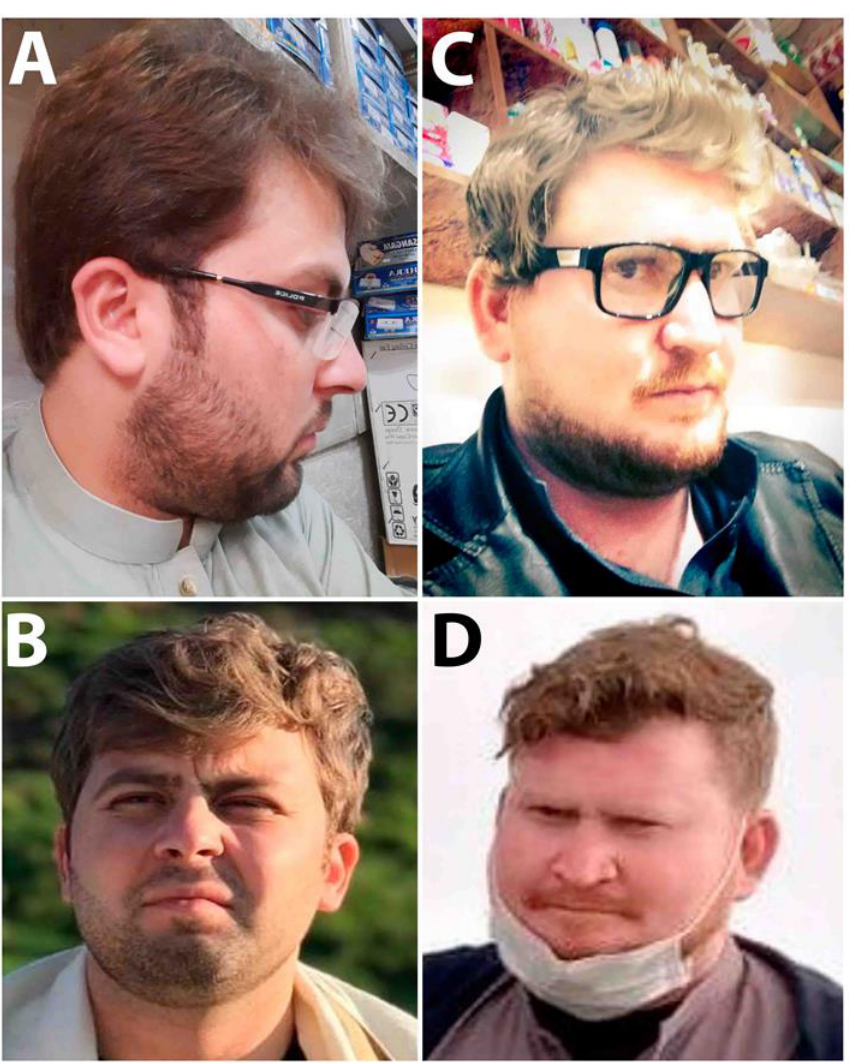
Figure 2. Clinical observations of ALB-09 ( A , B ) and ALB-10 ( C , D ) show hypopigmented eyes, skin, hair, and photophobia while no sign of easy bruising on the skin was observed. hair, and photophobia while no sign of easy bruising on the skin was